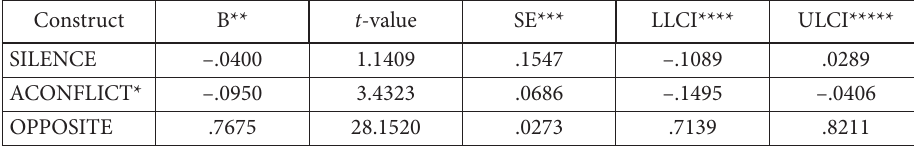
Table 4. Coefficient estimates for ordinary least squares model (source: created by authors) Construct